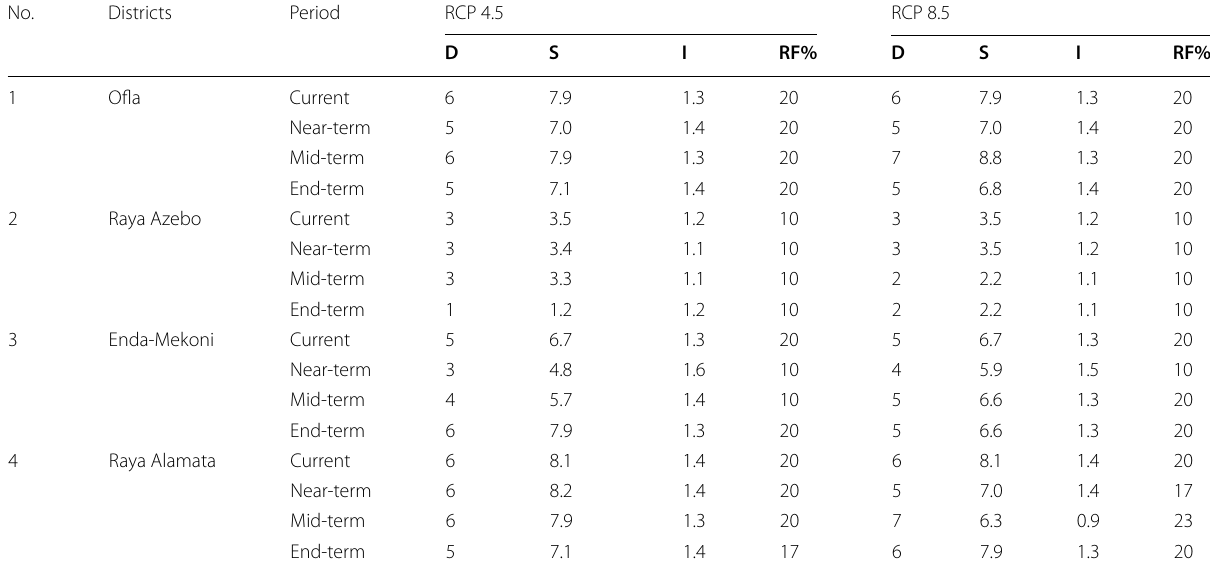
D Length of drought (Duration) in the year, S Severity, I Intensity, RF relative frequency